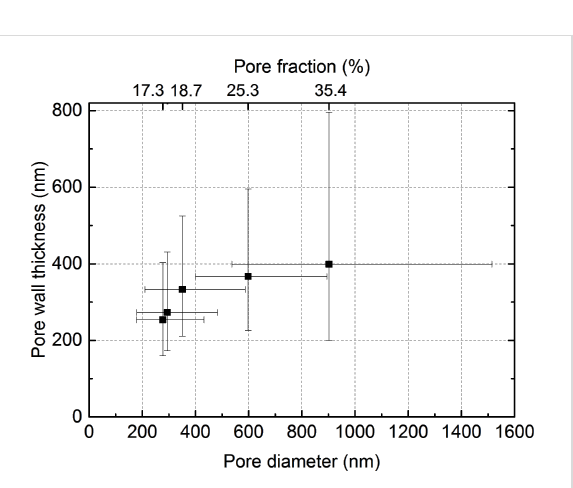
neat PMMA measured with nanoindentation is comparable to the bulk elastic modulus provided by the manufacturer (2800 MPa and 3300 MPa, respectively) and with other clearly depend on the measurement location and they decrease for every measured frequency within the morphological transi- tion from micro- to nanoporous foam. In the region with